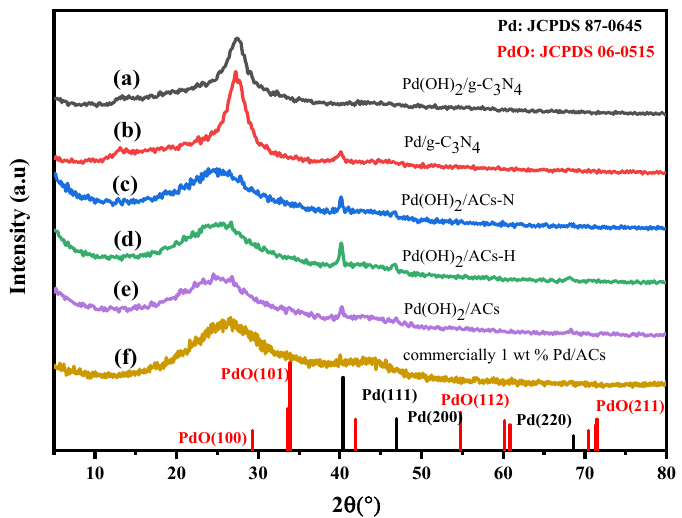
Figure 2. XRD patterns of the selected catalysts. ( a ) 1.1 wt% Pd(OH) 2 /g-C 3 N 4 , ( b ) 1.2 wt% Pd/g-C 3 N 4 , ( c ) 1.2 wt% Pd(OH) 2 /ACs treated by HNO 3 (labelled as Pd(OH) 2 /AC-N), ( d ) 1.4 wt% Pd(OH) 2 /ACs after hydrothermal treatment (labelled as Pd(OH) 2 /AC-H), ( e ) 1.2 wt% Pd(OH) 2 /ACs without treatment, ( f ) commercially 1.0 wt% Pd/ACs.